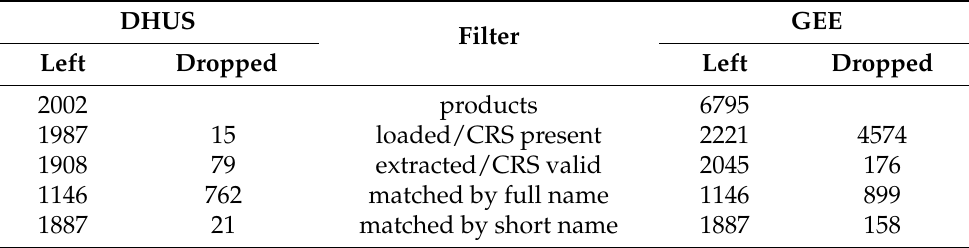
Table 1. Statistics on image